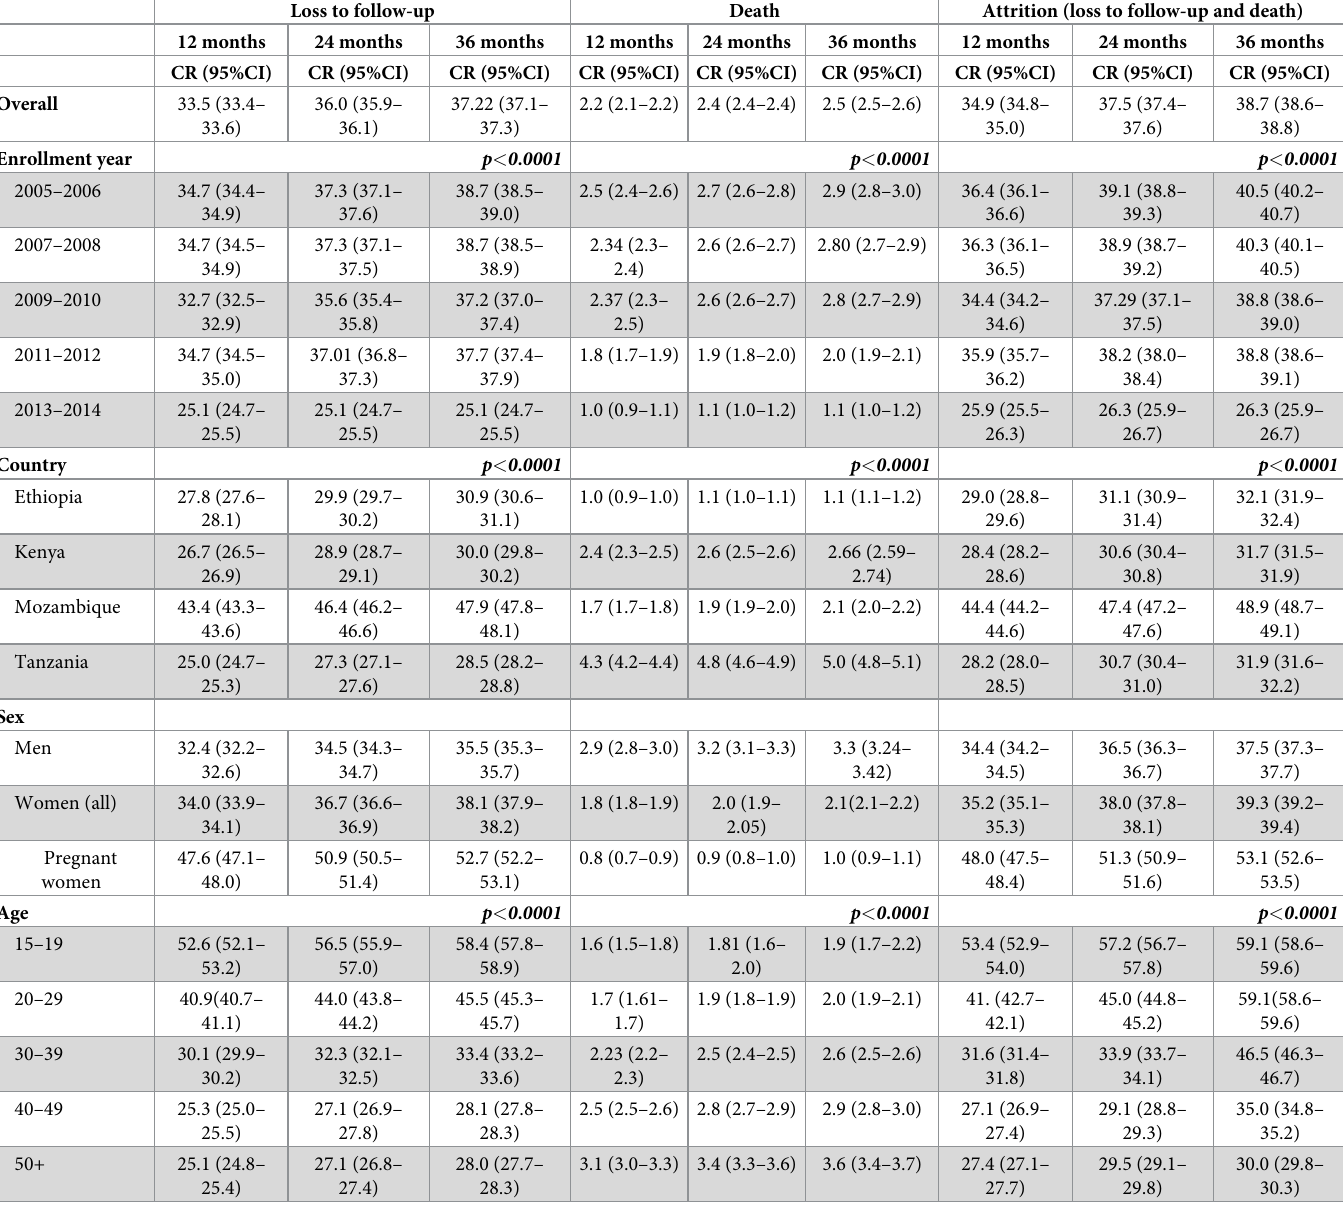
Table 2. Cumulative risk of pre-ART loss to follow-up, death and combined attrition for adults ( > = 15 years) enrolled at ICAP-supported health facilities in Ethio- pia, Kenya, Mozambique and Tanzania 2005–2014 (N =